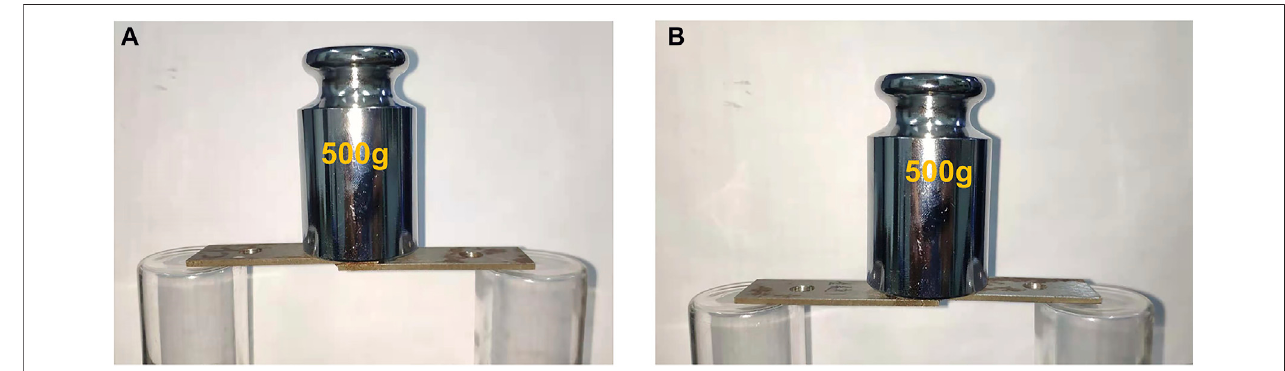
FIGURE 12 | Images of adhesive performance test bonding by hydrogen bonding SEs (A) and covalent bonding SEs (B) .